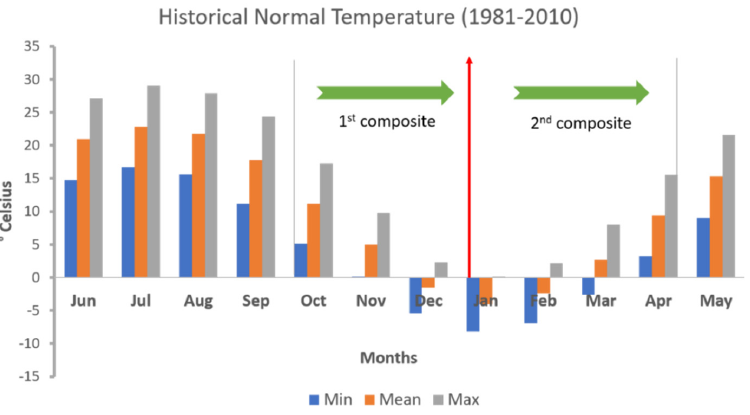
Figure 2. Historical minimum, maximum and mean temperature for the MRW.